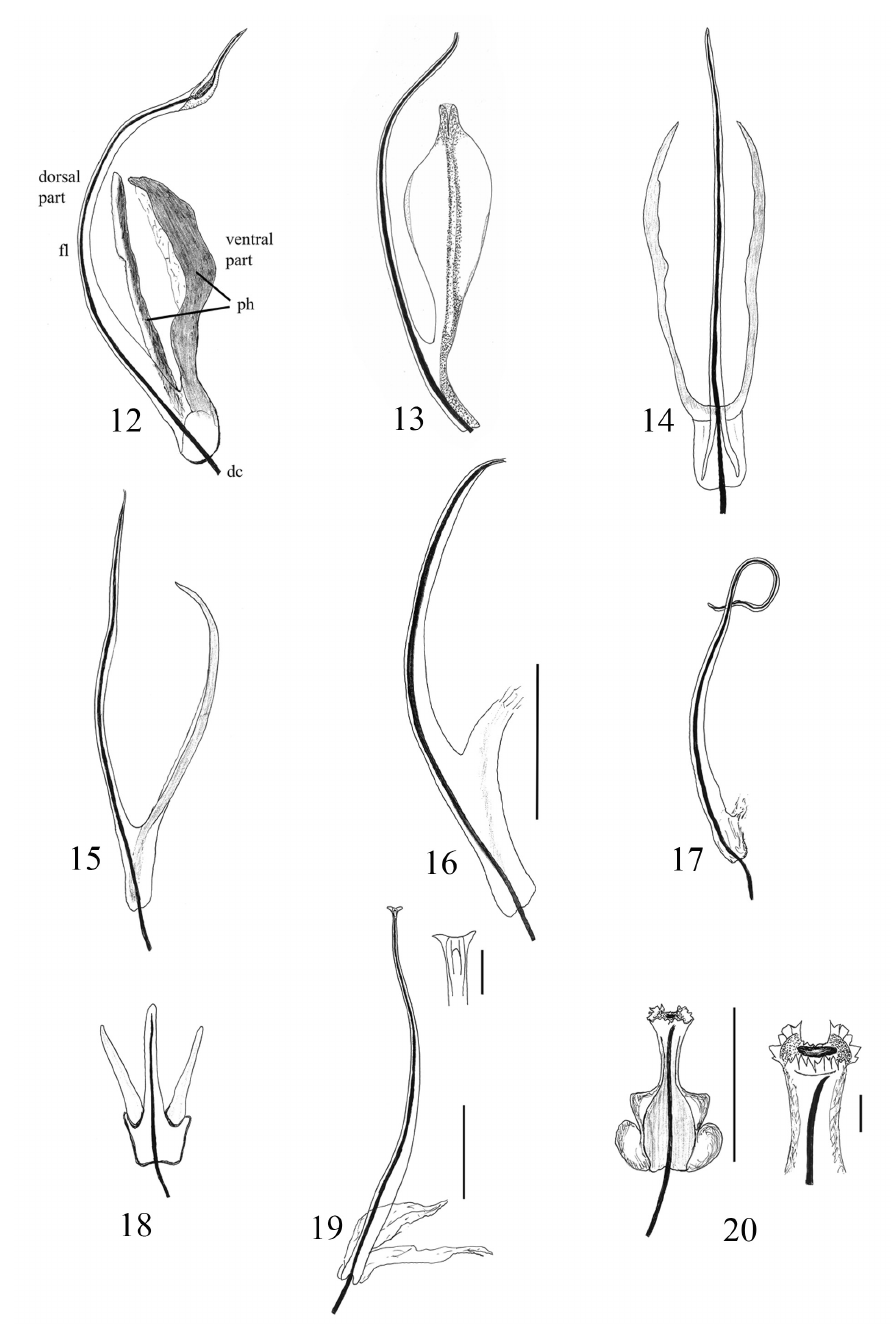
Figs 12–20. Sclerites of the internal sac of aedeagus. 12 . Timarcha tenebricosa (Launceston, England; dorsolateral). 13 . T. goettingensis (Germany, Bad Frankenhausen; dorsolateral). 14 . T. rugosa (Algeria, Batna; dorsal). 15 . T. hispanica (Spain, Madrid, Escorial; lateral). 16 . T. intermedia (Spain, Granada, Castell de Ferro; lateral). 17 . T. balearica (Spain, Palma de Mallorca; lateral). 18 . T. maroccana (Morocco, Middle Atlas, Sidi Ali; dorsal). 19 . T. (Americanotimarcha) intricata (U.S.A., Washington State; lateral). 20 . T. (Metallotimarcha) metallica (Croatia, Dundovici; ventral). Abbreviations: fl = flagellum; dc = ductus; ph = phanera. Scale bars: 12–18 = 0.5 mm; 19–20: short scale = 0.05 mm, long scale = 0.5